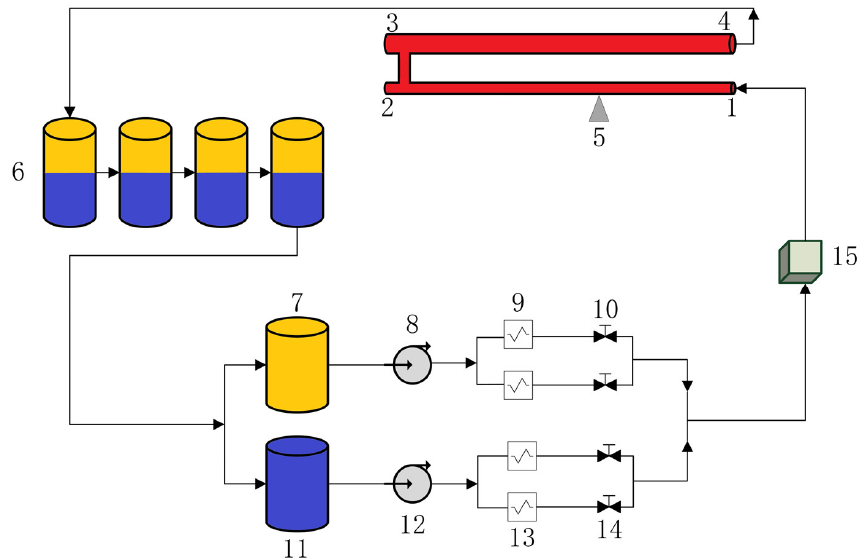
Figure 1. Schematic diagram of multi-phase flow simulation device for horizontal and high-angle deviated well. 1–2. A simulated wellbore (inner diameter of 124 mm), 3–4. B simulated wellbore (inner diameter of 159 mm), 5. Experimental observation site, 6. Oil–water four-stage separation tanks, 7. Oil tank, 8. Oil pump, 9. Oil flow meters, 10. Oil control valves, 11. Water tank, 12. Water pump, 13. Water flow meters, 14. Water control valves, 15. Oil–water mixer. Yellow represents oil, and blue represents water.